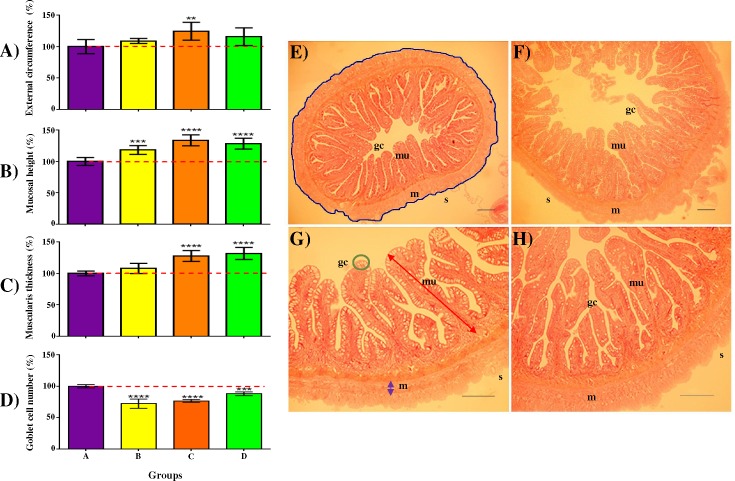
The gastrointestinal tract of Asian seabass is influenced by the different feeds.External circumference of serosa (Panel A), mucosal height (Panel B), muscularis layer thickness (Panel C) and goblet cell number (Panel D) were measured from sections of the mid gut of 168 dph-old Asian seabass fed frozen baitfish (Group A) or pelleted commercial feeds (Groups B-D) for 61 days. Values are represented as percentages over control (A) value. Post ANOVA Dunnett’s multiple comparisons test was performed between the mean of each group with the mean of the control group. Means significantly different from Group A are noted with *—Padj < 0.05; **—Padj < 0.01; ***—Padj < 0.001; or ****—Padj < 0.0001. Representative examples of the mid-gut histological sections are shown on the right (Panels E&G–Group A; F&H–Group C). Panel E: Blue line = External circumference of serosa (S); Panel G: red = high of Mucosa (mu), purple = Thickness of muscularis layer (m), green = Goblet cells (gc); Panels E&F - 5x magnification; Panels G&H - 10x magnification. Panels E&H; scale bar = 100μm.